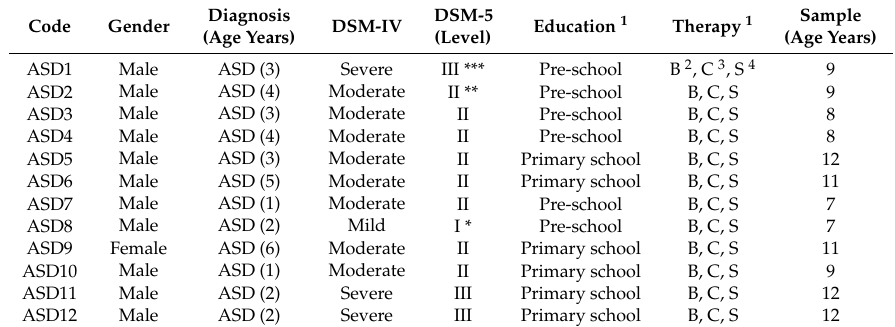
Table 1. Clinical data and demographic information of the children with Autism Spectrum Disorders who participated in this